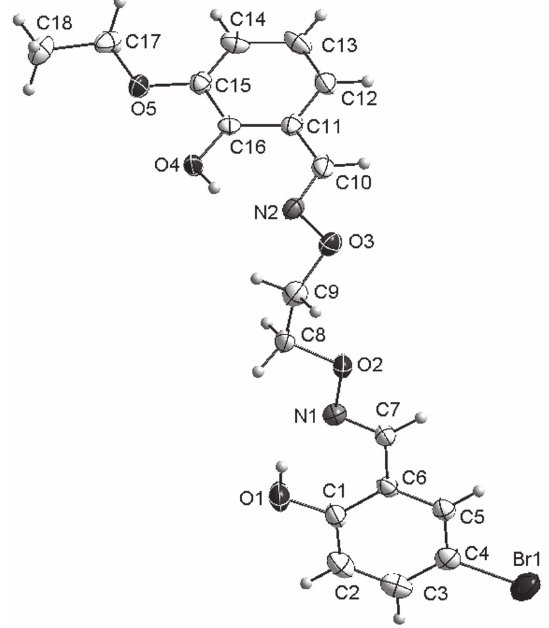
Table 1: Data collection and handling.